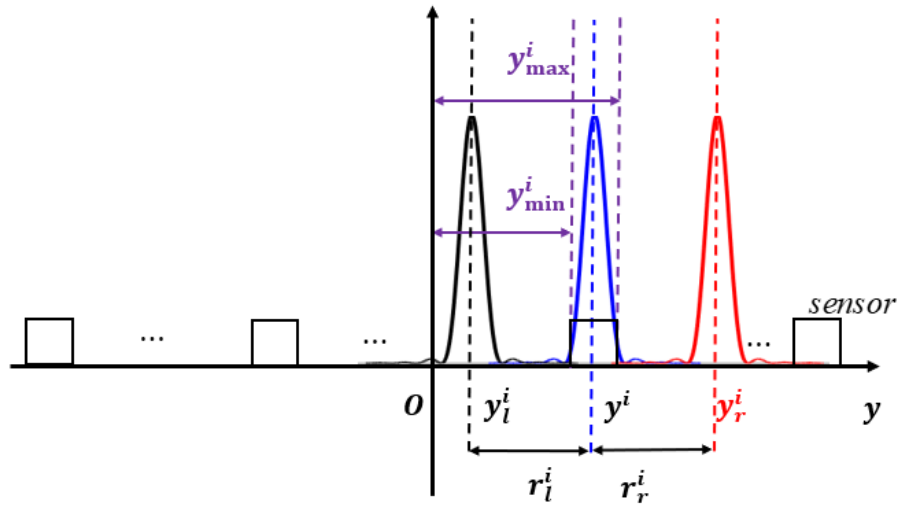
Figure 4. Relationship between the diffraction range of each wavelength and pixel.